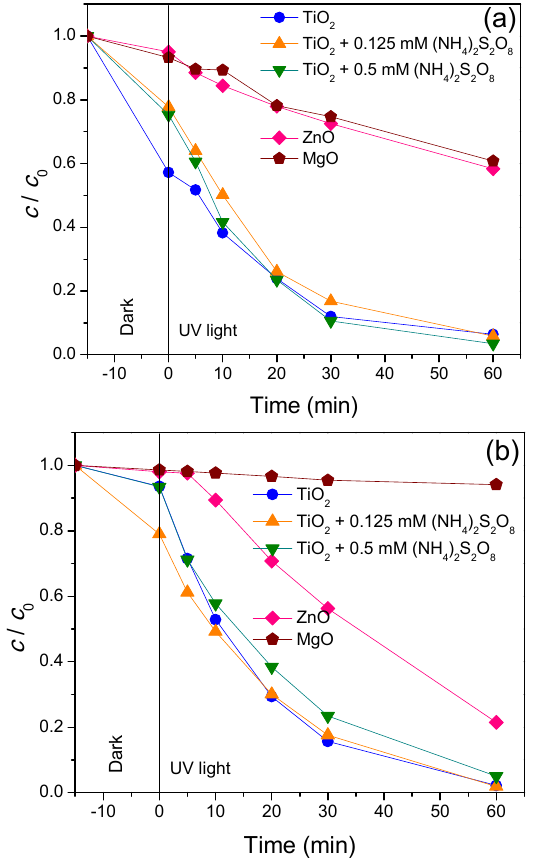
Figure 9. Removal of herbicides ( a ) TEM and ( b ) FLU (0.05 mM) from water using different catalysts (0.5 mg/mL) in the presence/absence of (NH 4 ) 2 S 2 O 8 under UV light. On the other hand, under SS radiation, TiO 2 removed TEM with lower efficiency of 64% during longer process time of 195 min (Figure 10a). Addition of 0.125 mM (NH 4 ) 2 S 2 O 8 led to a slightly higher removal of TEM (76%), while concentration of 0.5 mM (NH 4 ) 2 S 2 O 8 practically had no effect (Figure 10a). The removal activity of ZnO and MgO over 195 min under SS showed that these nanopowders were inactive regarding the removal of TEM (Figure 10a). Herbicide FLU results exhibited that the highest removal had TiO 2 where efficiency was 47% after 195 min of process (Figure 10b), while activity of ZnO was lower than TiO 2 (23%). Substrate removal was practically nonexistent with MgO. The addition of (NH 4 ) 2 S 2 O 8 increased removal activity for TiO 2 nanopowder, where both concentrations of (NH 4 ) 2 S 2 O 8 increased the removal activity of TiO 2 at 16% and 8%, respectively. Based on the all obtained results, it can be seen that, as in the case of antibiotics, the herbicides removal efficiency were somewhat slower using SS.